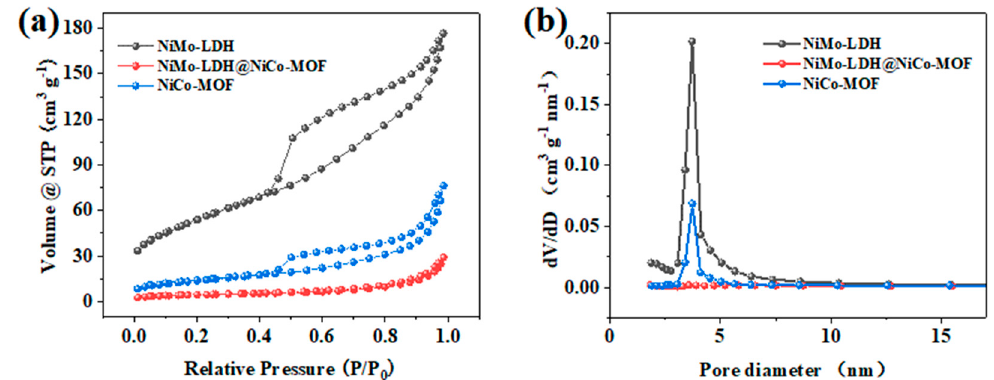
Figure 8. ( a ) Nitrogen adsorption and desorption curves; ( b ) pore size distribution.